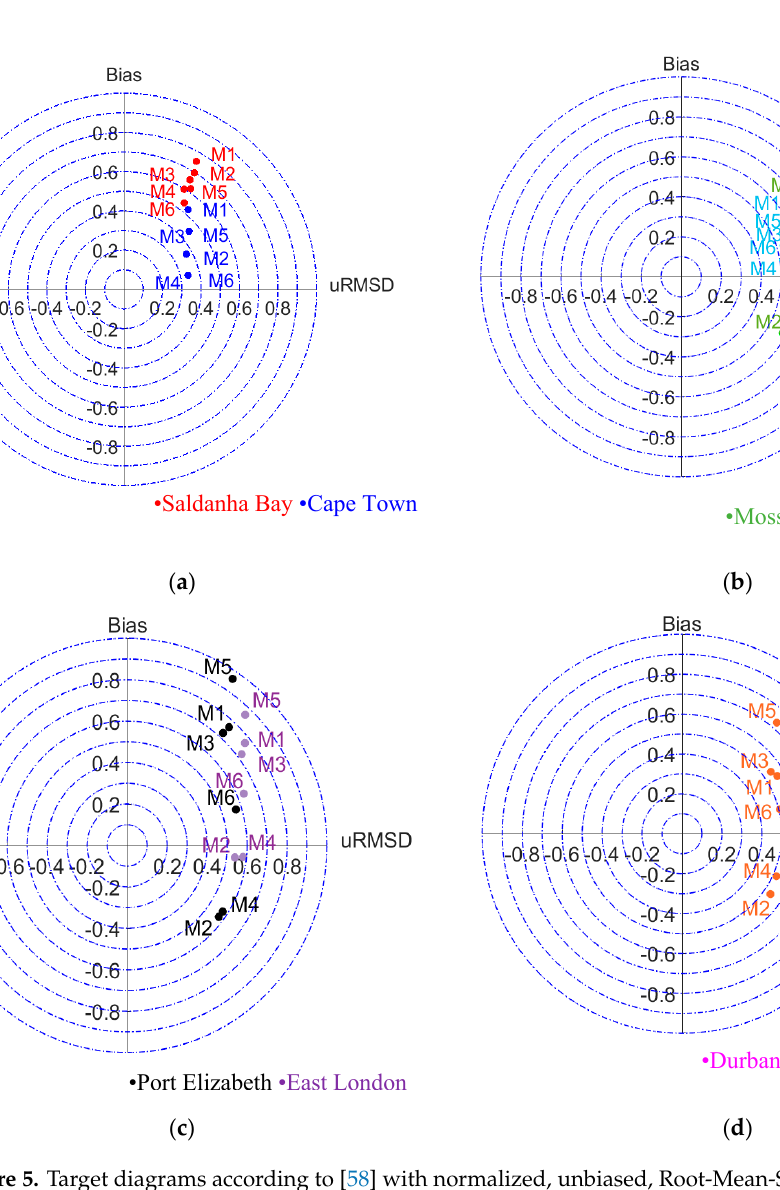
Figure 5. Target diagrams according to [58] with normalized, unbiased, Root-Mean-Square Difference (uRMSD) H m0 against normalized bias for ( a ) the western coast, ( b ) the southern coast, ( c ) the southeastern coast, and ( d ) the eastern coast .